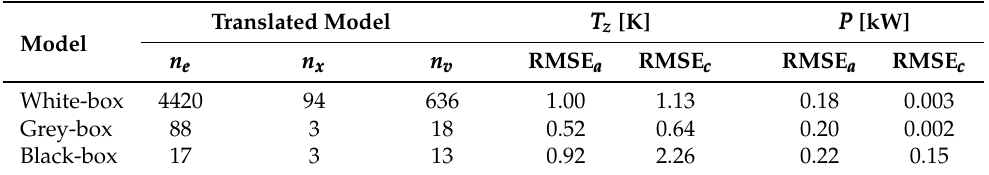
Table 3. Summary of model structures and their fitting to historical data. n e is the number of equations of the original model; n x and n v are the number of states and variables after symbolic manipulation, respectively. The RMSE is evaluated in auto- (RMSE a ) and cross- (RMSE c ) validation. Translated Model T z T z T z